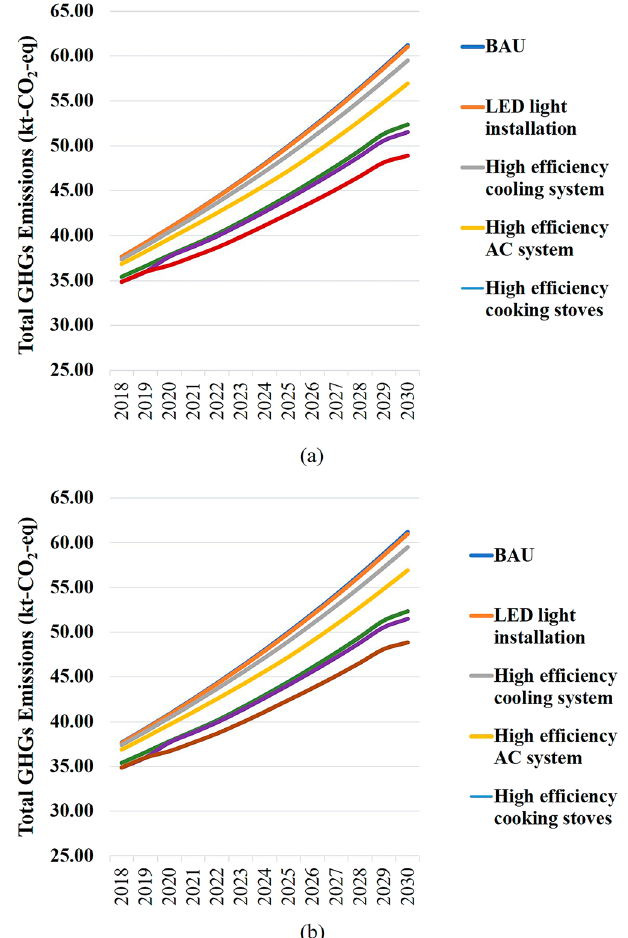
Figure 3. Estimated GHG emissions from the residential sector of Ayutthaya Municipality and mitigation scenarios based on Thailand’s NDC Roadmap assuming ( a ) 4.13% annual provincial economic growth rate and ( b ) 1.12% annual municipality economic growth rate.